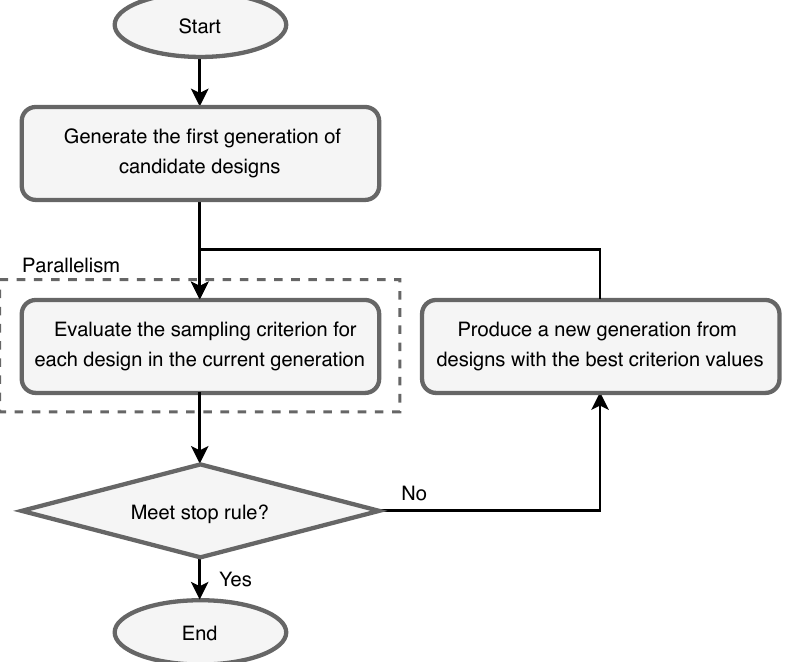
Figure 8. The procedure of GA for sampling